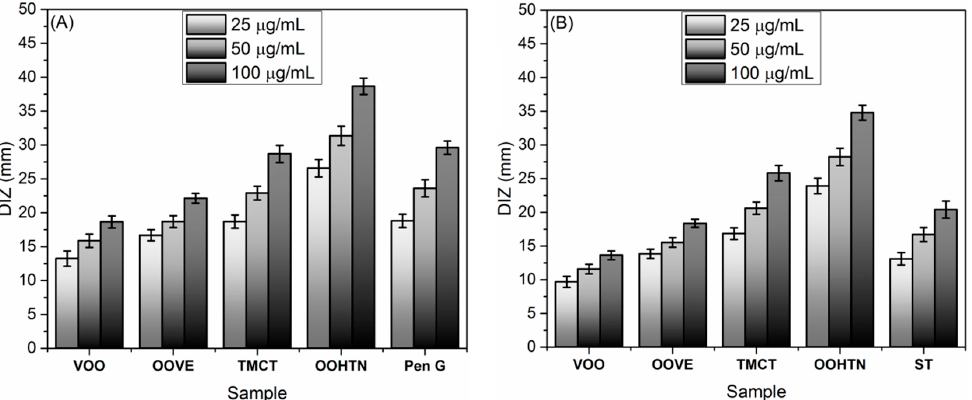
Figure 6. DIZ graph for VOO-nanoformulations and their native ingredients against ( A ) S. aureus ( SA ) and ( B ) E. coli ( EC ). Pen G = Penicillin G and ST = Streptomycin were used as negative controls.